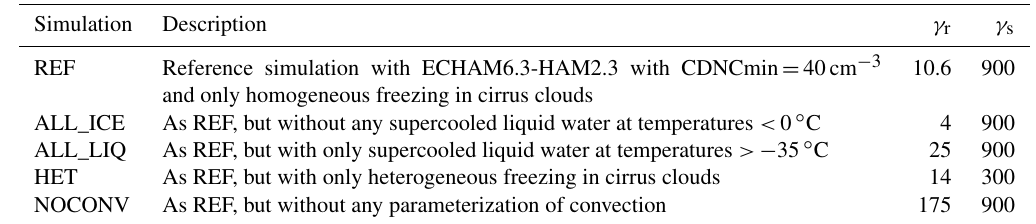
Table 1. Set-up of the simulations together with the two tuning parameters that differ among the simulations.